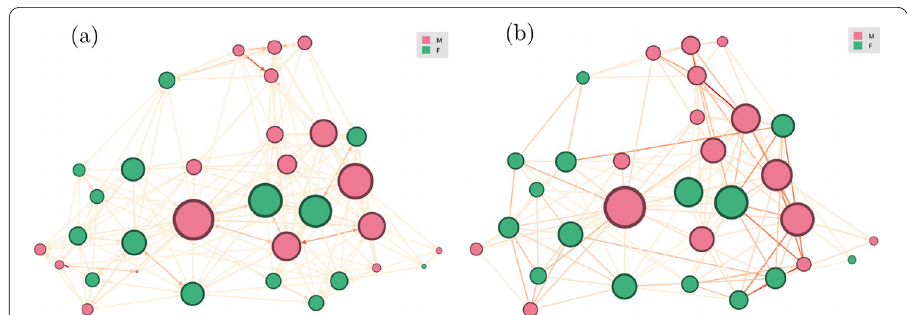
Figure 1 Graphical representation of yearly aggregated networks. ( a ) Communication network. ( b ) Co-presence network. Nodes are colored by gender (“M” for male and “F” for female), and their size depends on their degree. Edges are colored by aggregated duration. For the co-presence network, only edges present as well in the communication network are shown. As a result, two nodes become isolated and are not represented